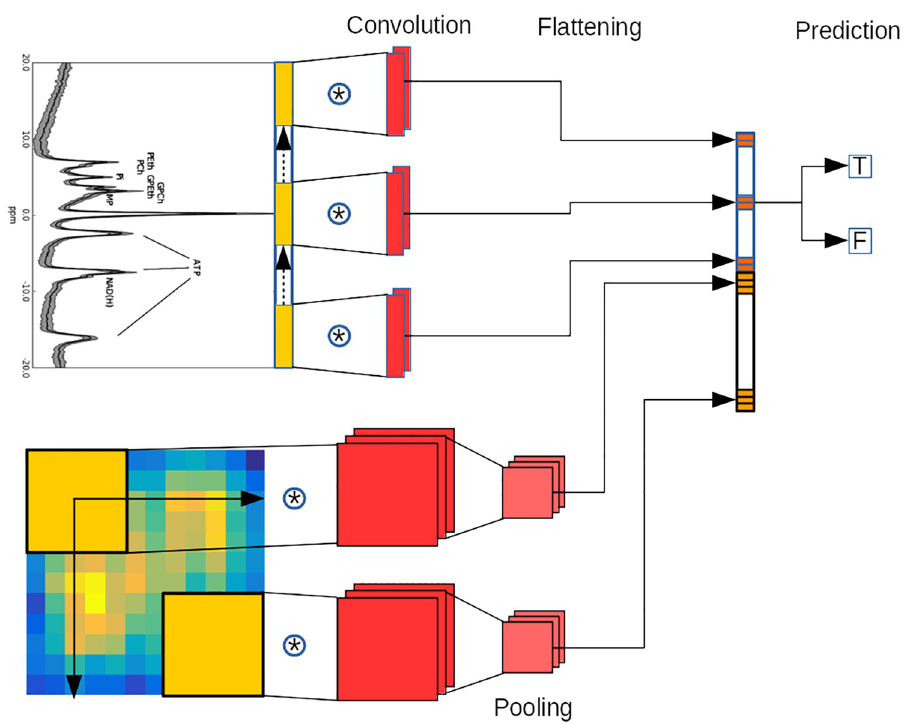
Fig 3. SL-CNN architecture and functioning for spectra and images for a 2 classes classification task (T or F to separate Alzheimer’s disease and normals). The convolution is performed by sliding each kernel of the convolutional layer over the input spectrum and the corresponding image. At every location (yellow), a vector or matrix multiplication for spectra or images respectively is performed and sums the result onto the feature map (orange). Then, a pooling layer is used to reduce the dimensionality of the convolutional layer output for images. Finally, the outputs from the different network branches are reshaped into a vector (flattening), merged and used for prediction (T or F). In this example, 2 kernels (red) are applied for spectra and 3 kernels (red) for